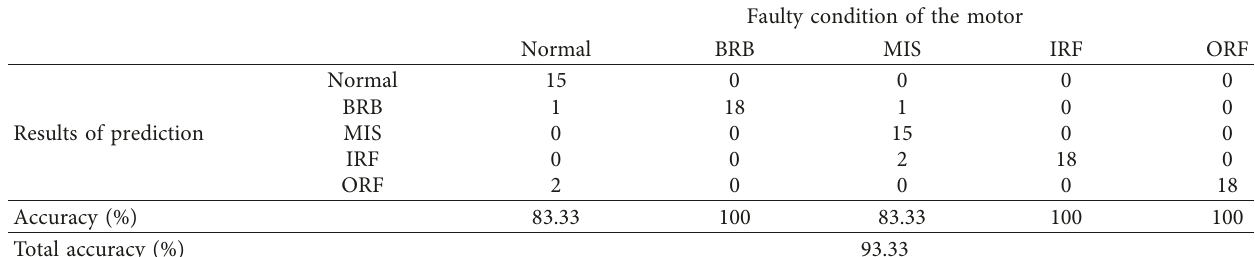
Table 12: Classification accuracy of the fusion